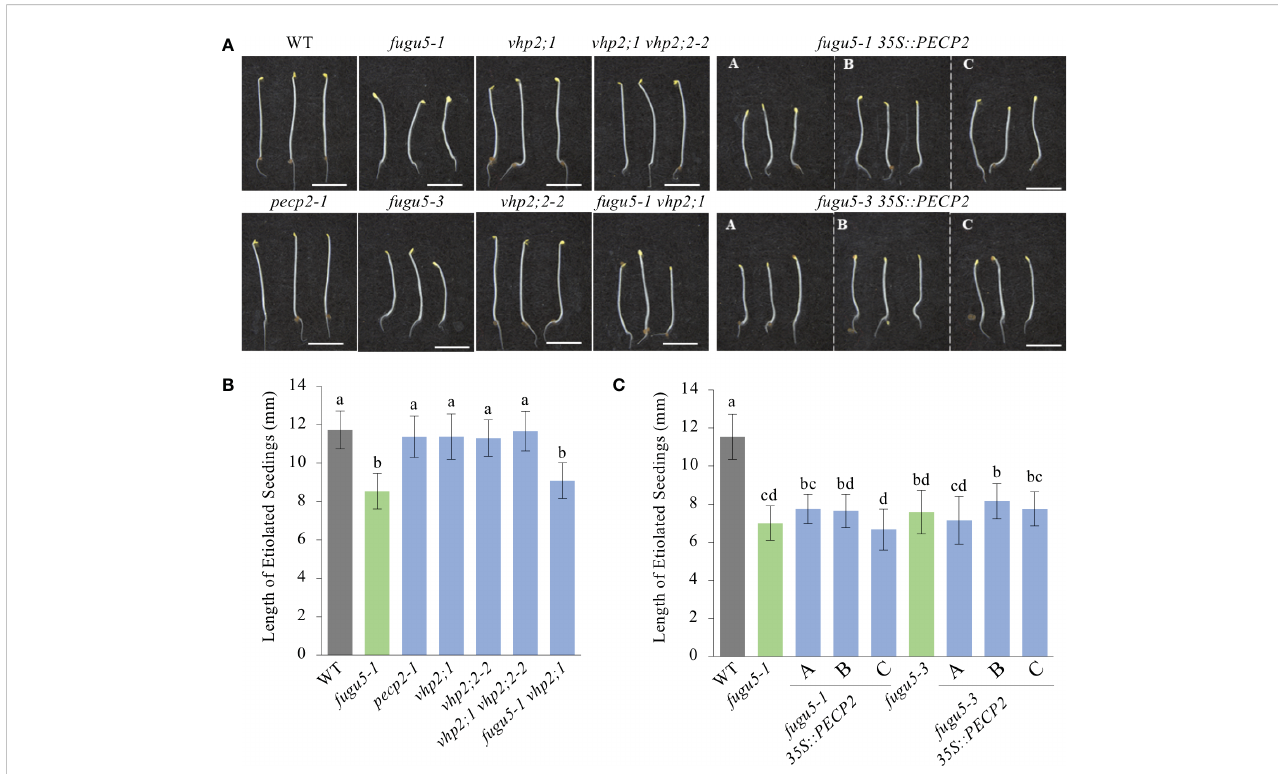
FIGURE 7 Quanti fi cation of hypocotyl length of etiolated seedlings. (A) Photographs of etiolated seedlings of the indicated genotypes grown on MS-only medium (without sucrose) in the dark for 4 DAI. Scale bar = 5 mm. (B) Hypocotyl length of etiolated seedlings of the WT, fugu5-1 , pecp2-1 , vhp2;1 , vhp2;2-2 , vhp2;1 vhp2;2-2 and fugu5-1 vhp2;1 lines grown on MS-only medium in the dark for 4 DAI. Data are means ± SD ( n = 20 seedlings). (C) Hypocotyl length of etiolated seedlings of the WT, fugu5-1 , fugu5-3 , fugu5-1 35S::PECP2 and fugu5-3 35S::PECP2 lines grown on MS-only medium in the dark for 4 DAI. Data are means ± SD ( n = 20 etiolated seedlings). Each character represents a signi fi cant difference at P< 0.05 (Tukey ’ s HSD test). DAI, days after induction of seed